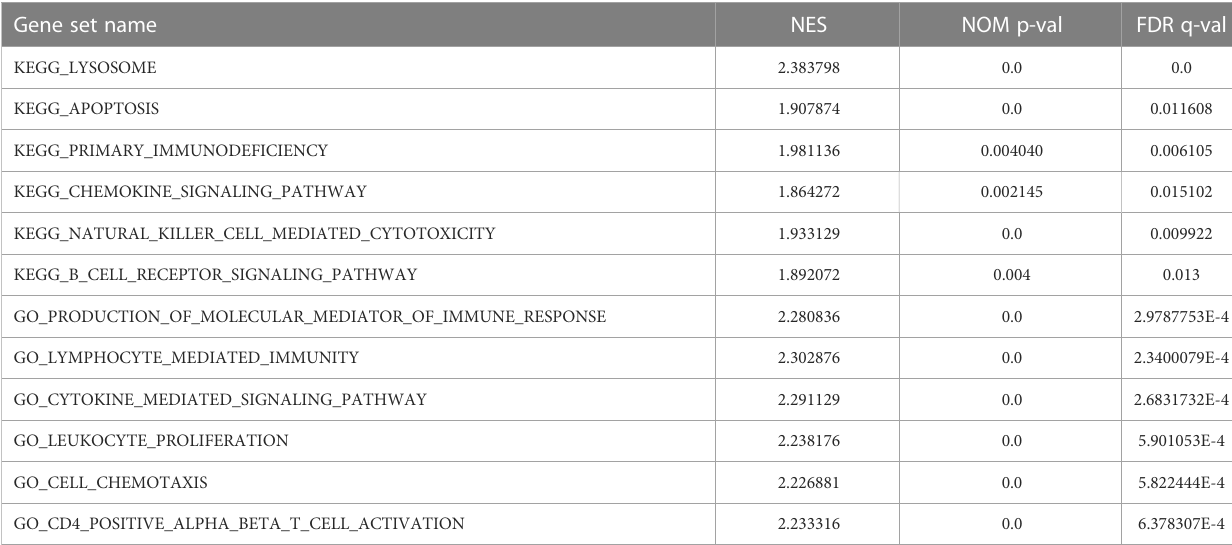
TABLE 2 Gene sets enriched in